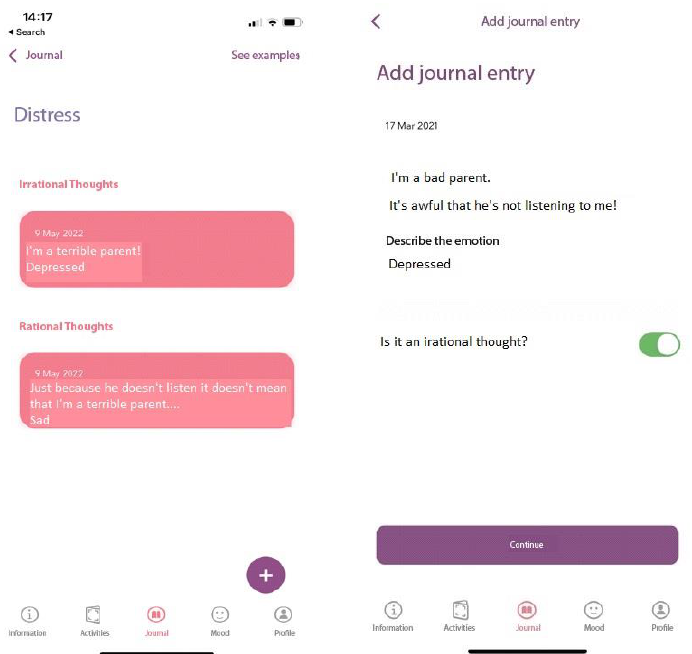
Figure 5. Cognitive Restructuring (Activities linked to Journal).